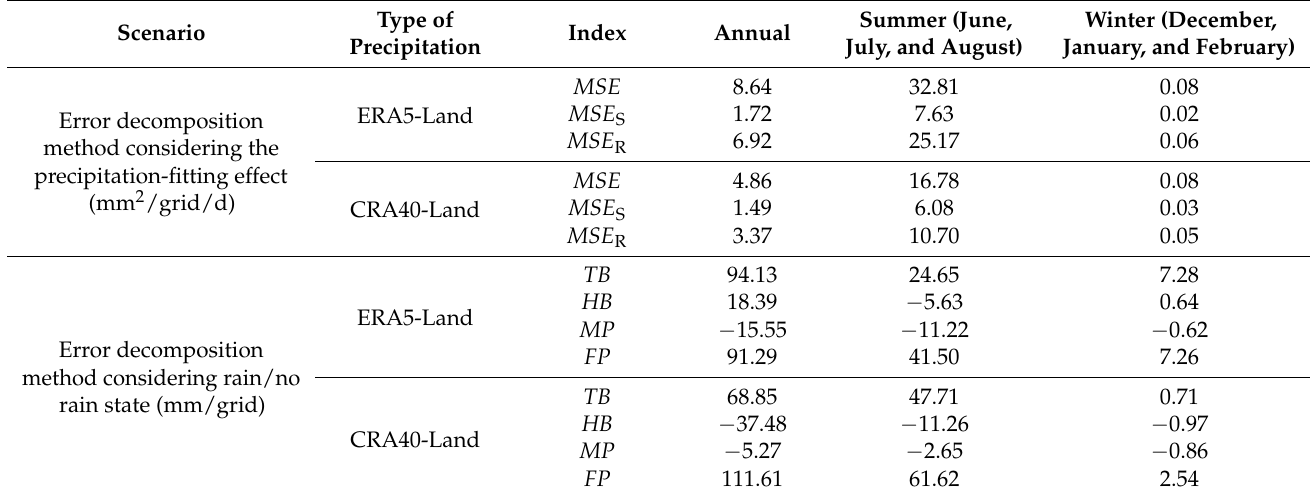
Table 2. Overall evaluation results of the two error decomposition